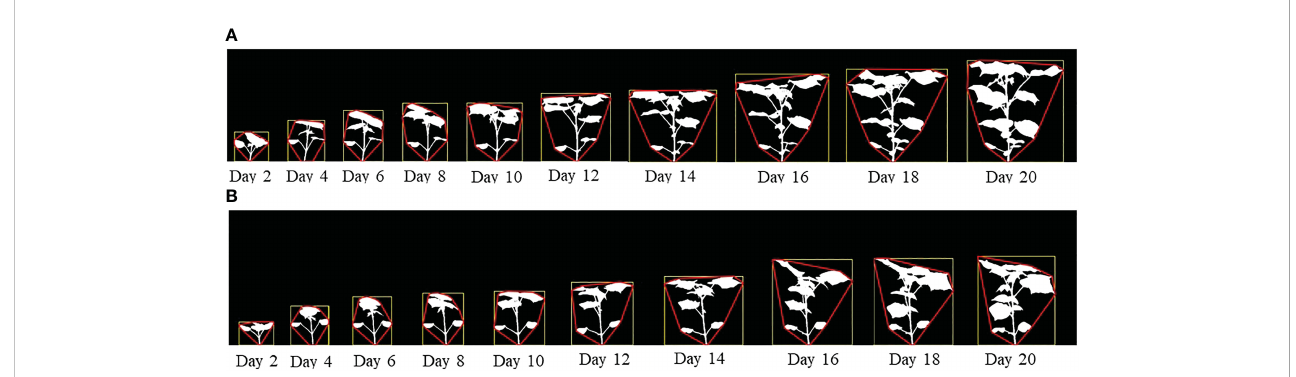
FIGURE 2 (A) An image sequence of a sample plant for side view angle of 0° (Experiment 1) enclosed by their bounding rectangles and convex hulls under controlled condition; and (B) An image sequence of a sample plant for side view angle of 0° (Experiment 1) enclosed by their bounding rectangles and convex hulls subjected to drought